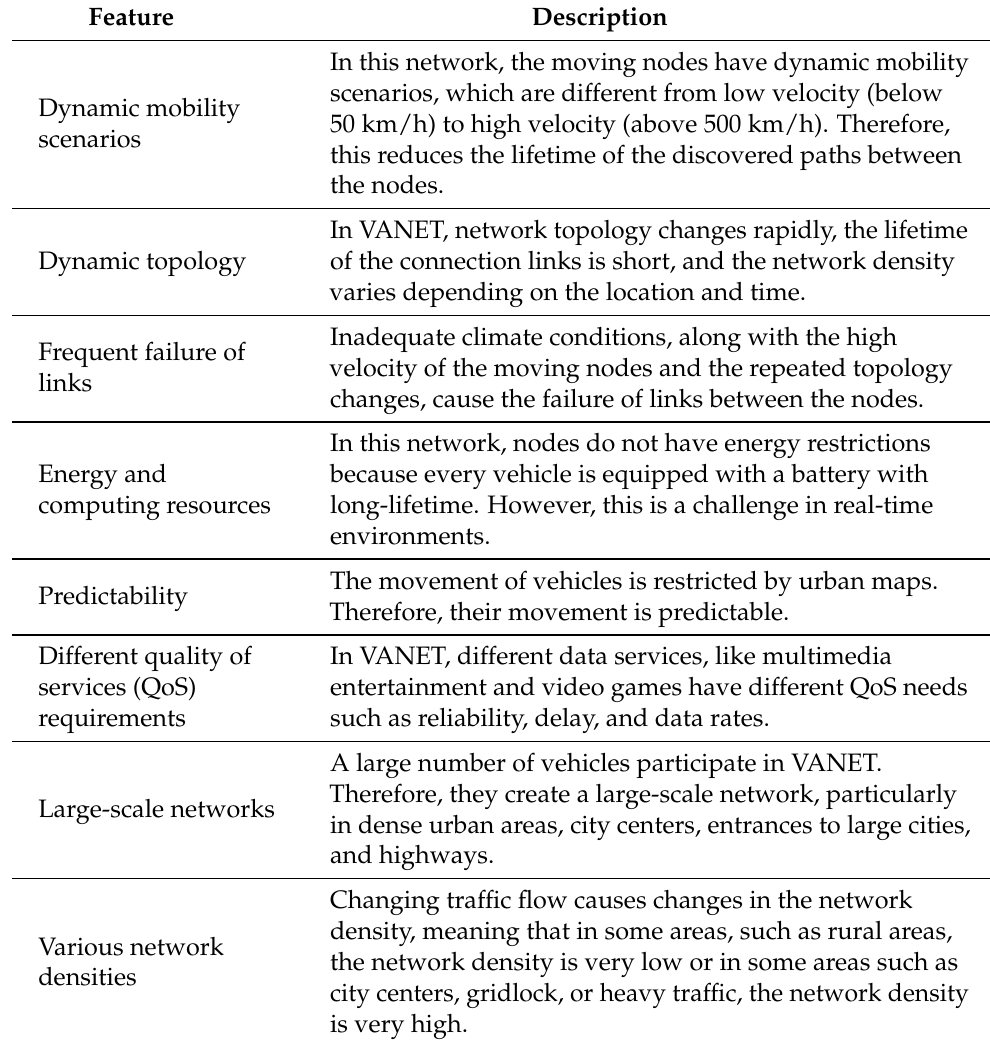
Table 1. Important features of vehicular ad hoc